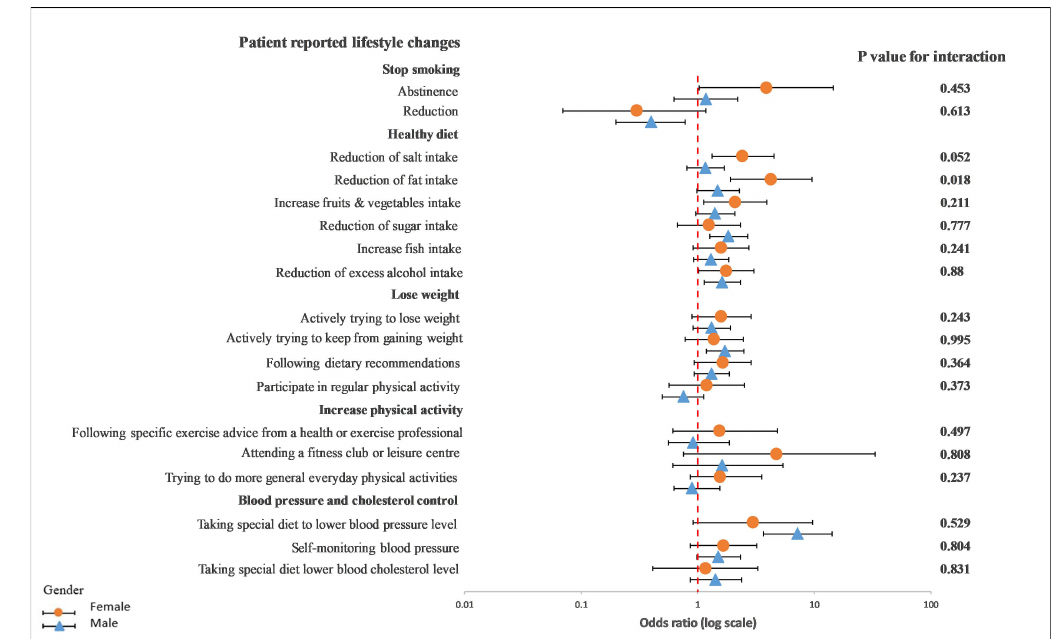
Figure 6. Multivariable logistics regression analysis between the recollection of risk factors and patients’ reported lifestyle changes. The p -value corresponds to the interaction between female and male patients. The model included the recollection of risk factors (PRRFI = 0 and GRRFI = 1) as the independent variable, patients’ reported lifestyle changes (no = 0 and yes = 1) as the dependent variables, and age at the index event (continous), the index event, and obesity, as well as diabetes at hospitilization, as the covariates. PRRFI: poor recollection of risk factor information; GRRFI: good recollection of risk factor